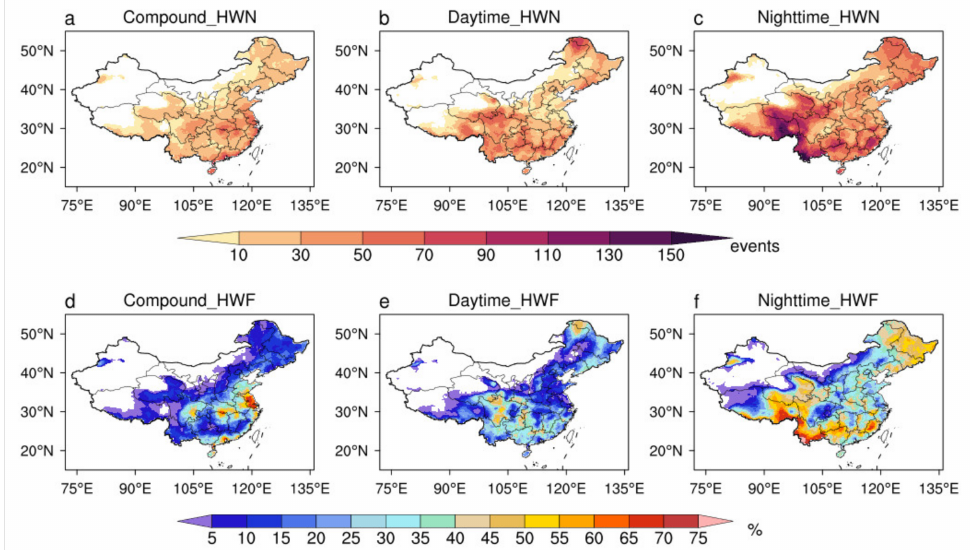
Figure 2. ( a – c ) Total number of wet compound, daytime and nighttime HW occurrences (HWN) during 1961–2020. ( d – f ) Percentage of wet compound, daytime and nighttime HW days (HWF) in total certain HW days. Blank areas, except Taiwan, indicate no wet HWs occurrence.